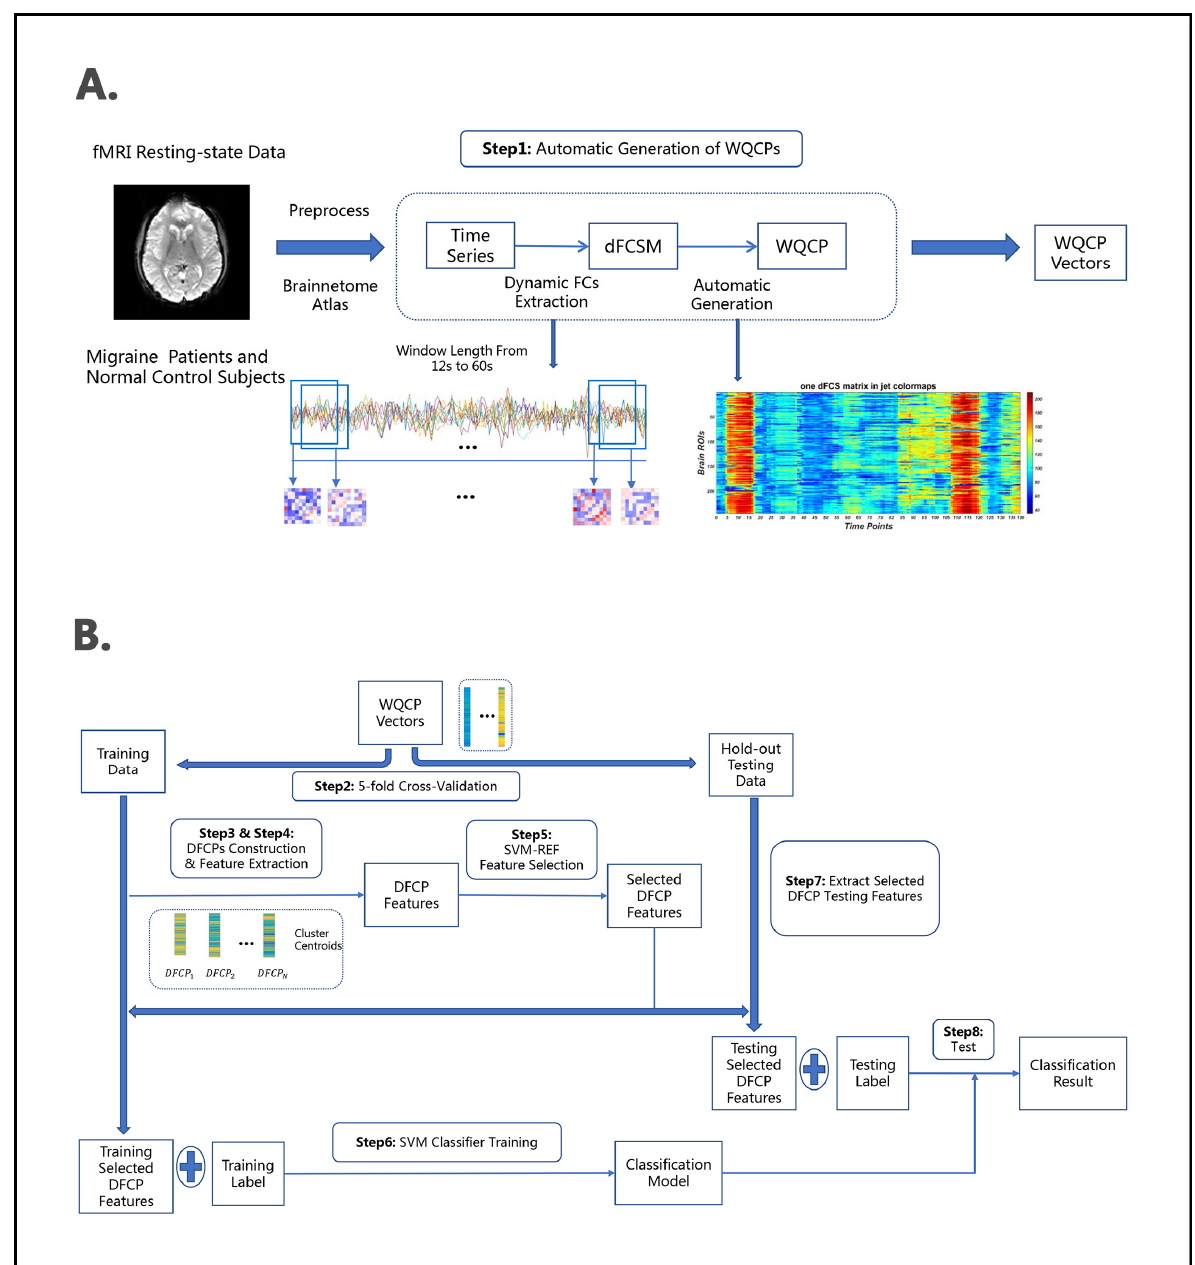
Figure 2. The framework of classification approach based on DFCP. ( A ) The preprocessed fMRI resting-state data were decomposed into 246 regions of interest (ROIs) by Brainnetome Atlas. The WQCP vectors were automatically generated from the resting-state functional connectivity (FCs) between the ROIs based on sliding time windows. ( B ) The WQCP vectors were clustered to obtain dynamic functional connectivity patterns and then the DFCP features were obtained. The DFCP features were sent into the feature selection and classification framework, which were performed on the basis of 5-fold cross-validation strategy. Both the migraine group and COBRE groups were divided into a training set and a test set, respectively, and ICBM group were used as test set. Selected features and SVM parameters were obtained from the migraine and COBRE training sets and were applied to the migraine and COBRE test sets. This process was repeated 100 times. This was followed by another 100 tests with the migraine and ICBM test sets. The final classification results were obtained for both sets of 100